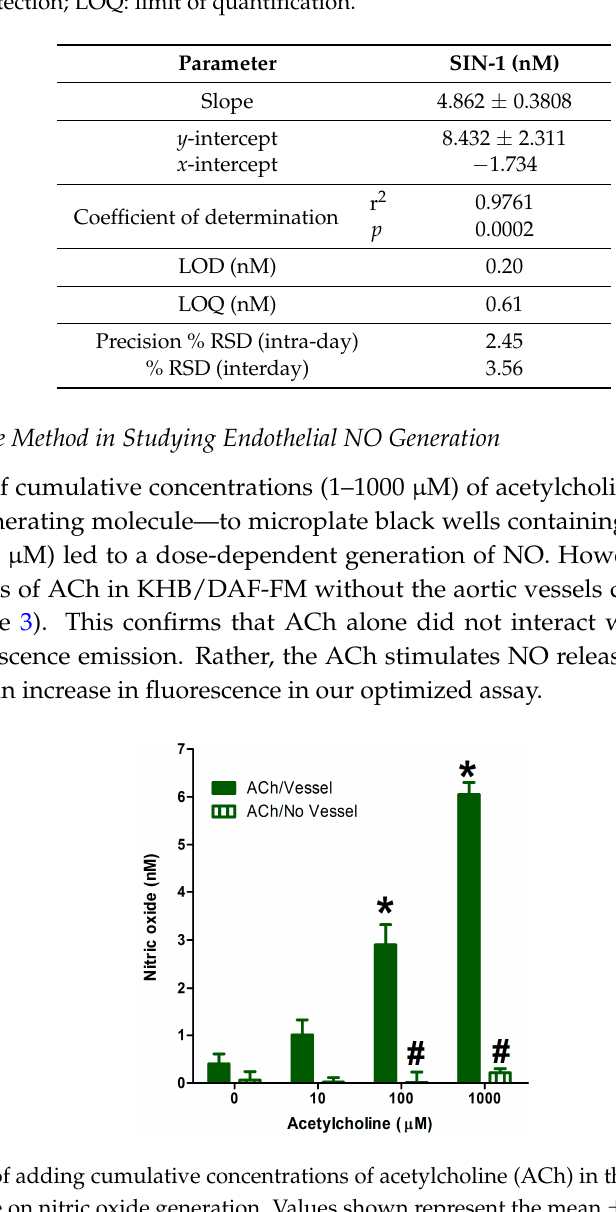
Molecules 2017 , 22 , 127